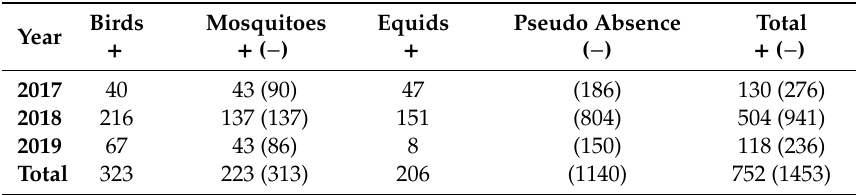
Table 1. Number of veterinary cases by year, animal category and status: positive ( + ), pseudo-negative in time and pseudo-absence in space ( −